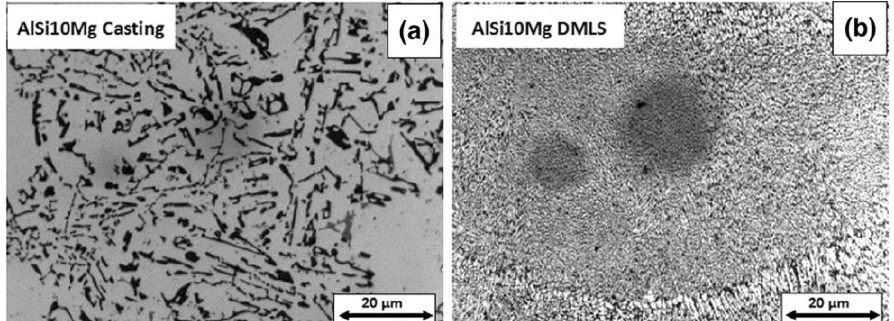
Figure 4. SEM of microstructures of 316L stainless steel produced by conventional process ( a ) and direct metal laser sintering (DMLS) ( b ). Reproduce from [43], with permission from Springer Nature, 2016.